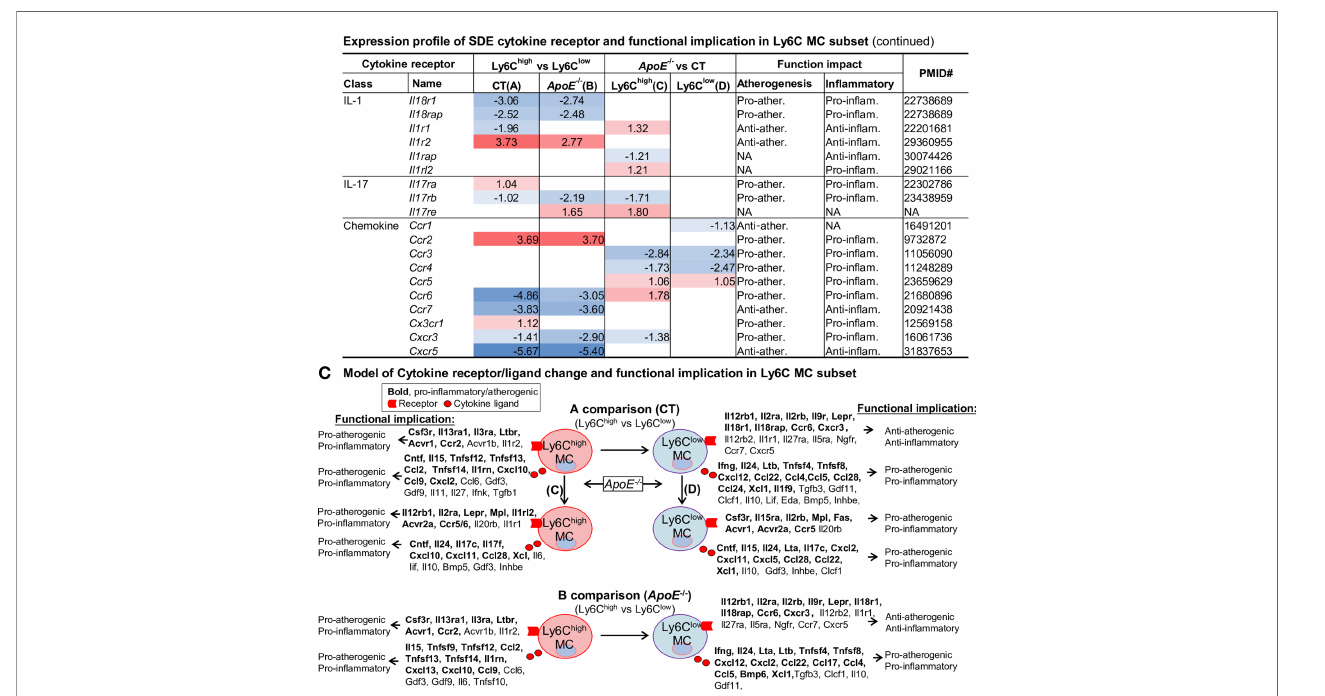
FIGURE 6 | Identi fi cation of SDE cytokine gene and function implication in Ly6C MC subset in CT and ApoE -/- mice. (A) Expression pro fi le of SDE cytokine ligand. Fifty-eight SDE cytokine ligand are identi fi ed in four comparison groups. (B) Expression pro fi le of SDE cytokine receptor and function implication. Fifty-two SDE cytokine receptor are identi fi ed in four comparison groups. There function implication are summarized based on literature search (PMID cited). Red/blue rainbow background represents the gradient of increased/reduced fold change (log 2 FC>1 and log 2 FC<-1, respectively). (C) Model of cytokine receptor/ligand change and functional implication. Functional implication is conclude based on cytokine ligand and receptor change. Bold letter emphasized pro-in fl ammatory and pro-atherogenic function. NA, Not